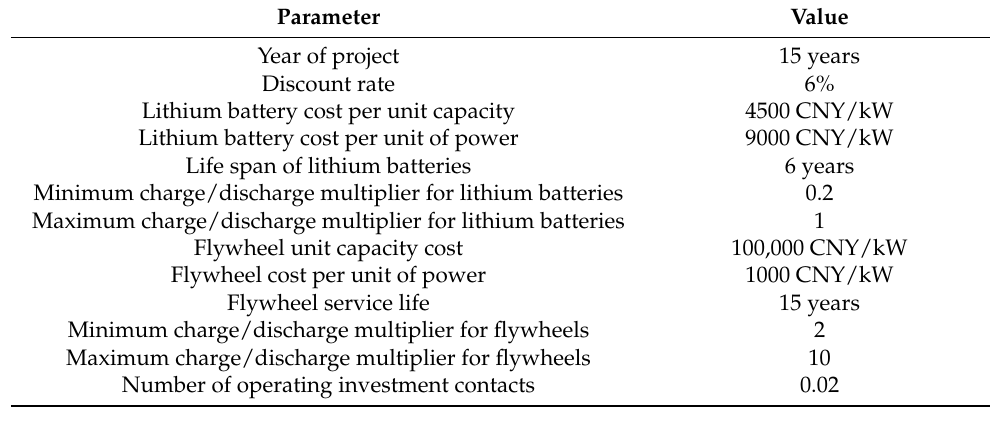
Table 4. Constant volume optimization data.